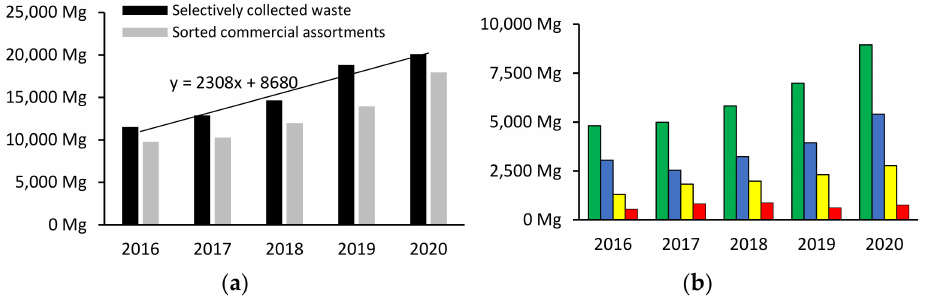
Figure 8. Characteristics of the selective waste stream generated in 2016–2020; ( a ) mass of selective waste and of recovered commercial assortments; ( b ) mass of different waste fractions; - glass, - paper, - plastic, - metal.